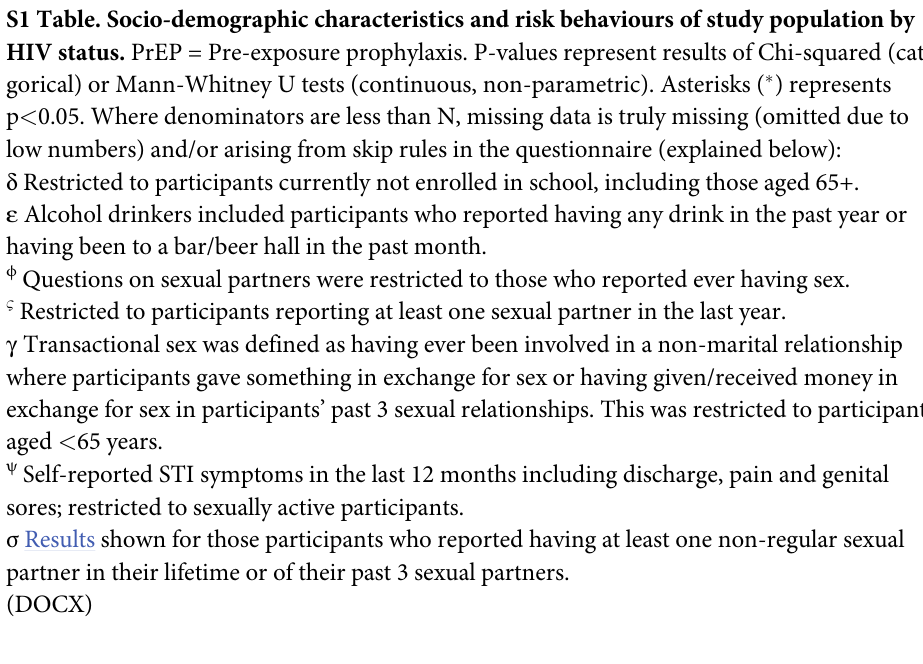
S3 Fig. Breakdown of weighted HIV seroprevalence across socio-demographic characteris- tics. Error bars represent 95% CI. S1 Table. Socio-demographic characteristics and risk behaviours of study population by HIV status. PrEP = Pre-exposure prophylaxis. P-values represent results of Chi-squared (cate- gorical) or Mann-Whitney U tests (continuous, non-parametric). Asterisks ( � )